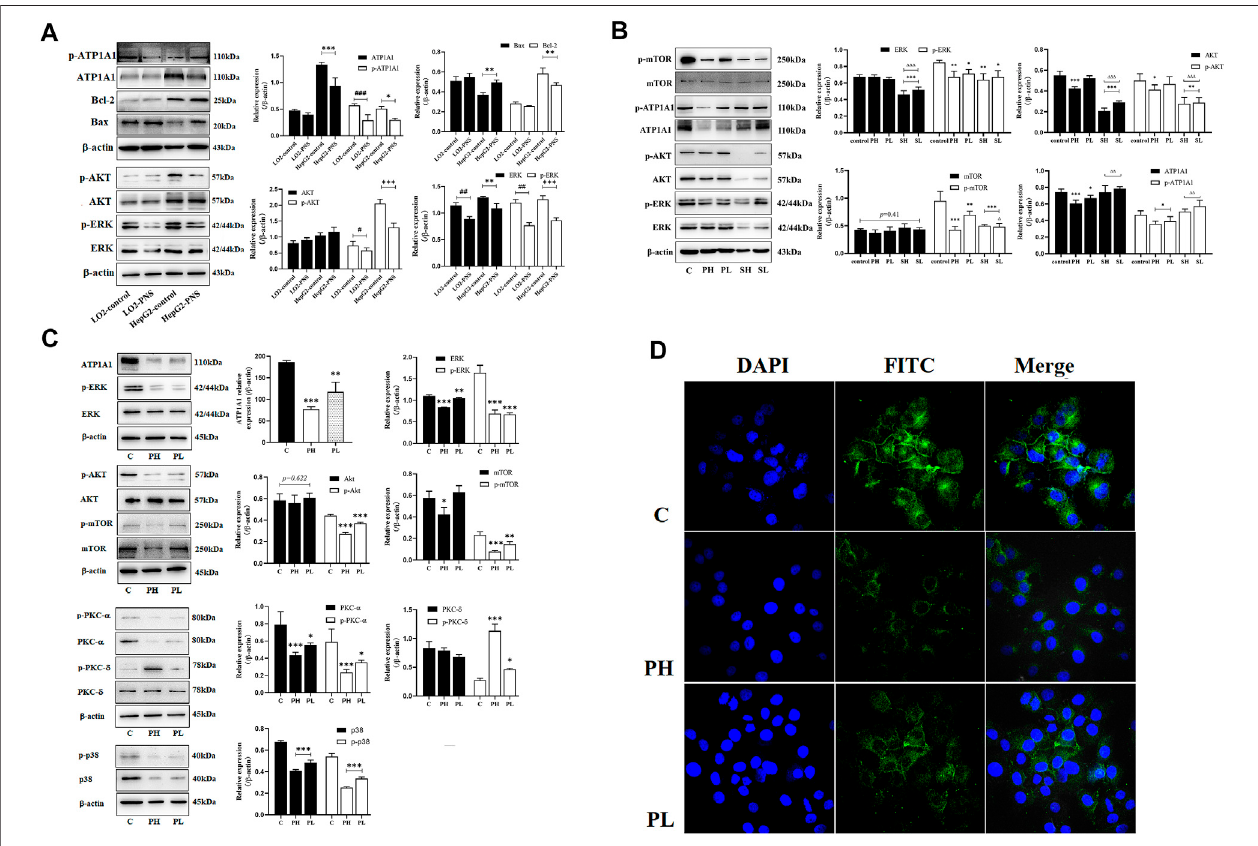
(cid:129) (cid:129) L − 1 ; SL: 10 μ moL L − 1 . (A) The effects ofPNS